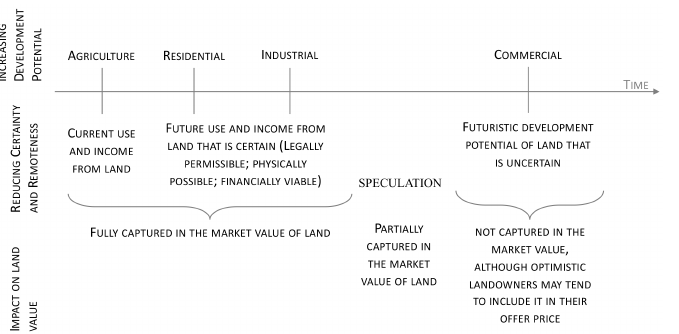
Figure 1. Schematic representation of the relationship between the development potential of land; probability of development; and the value of land over